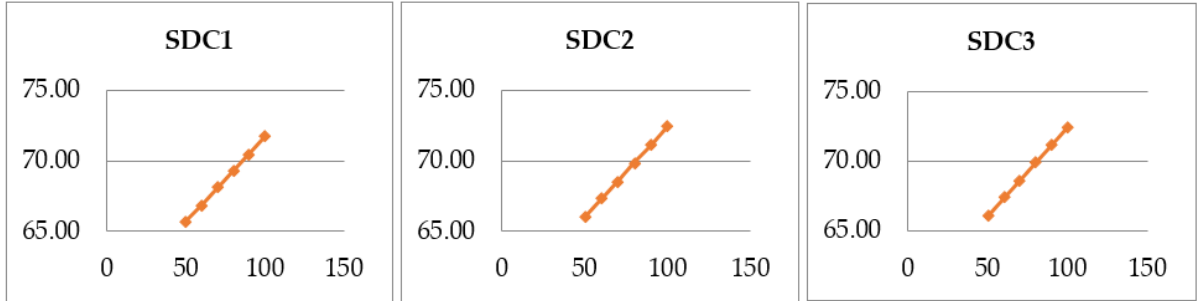
Figure 1. Return rate (%) depending on the motility (%) nested within the sperm count in a dose (SDC1: ≤ 2.50 × 10 9 ; SDC2: 2.51–4.00 × 10 9 ; SDC3: ≥ 4.01 × 10 9 ).